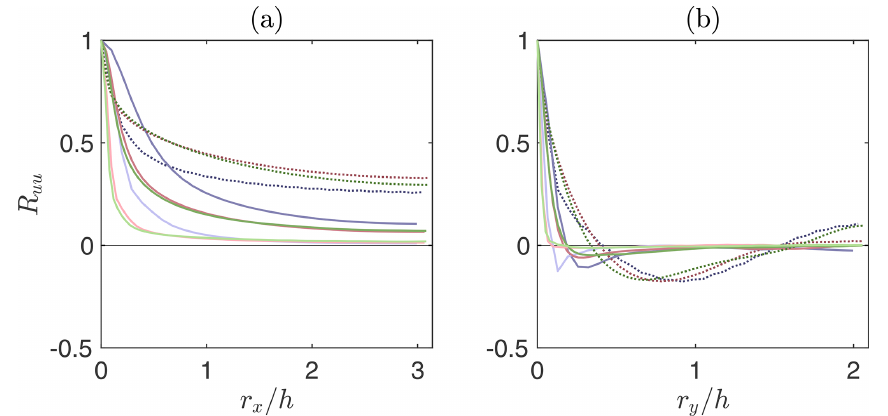
Figure 5. One-dimensional spatial autocorrelation of streamwise velocity at height z/h ≈ 0 . 1 along the streamwise direction (a) and along the cross-stream direction (b) . Lines as in Fig.